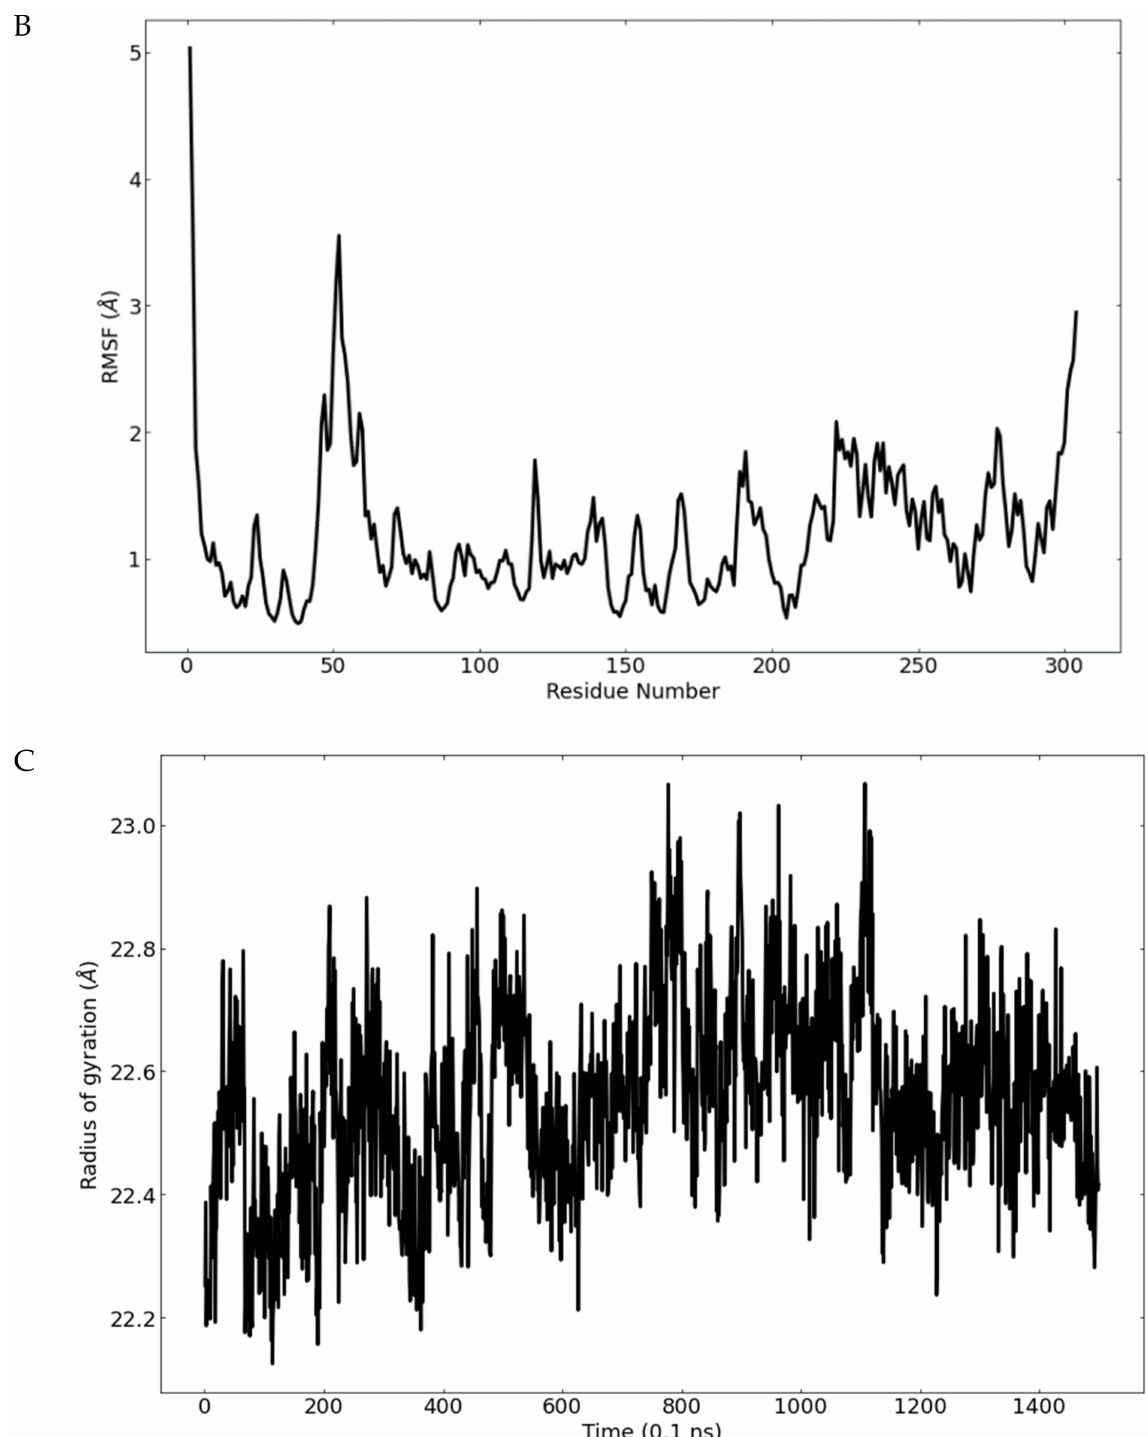
Figure 10. Molecular dynamics simulations of caprolactin A-M pro complex. ( A ) RMSD analysis of caprolactin A bindings with M pro . ( B ) RMSF plot of VGL residues. ( C ) Radius of gyration for M pro within 150